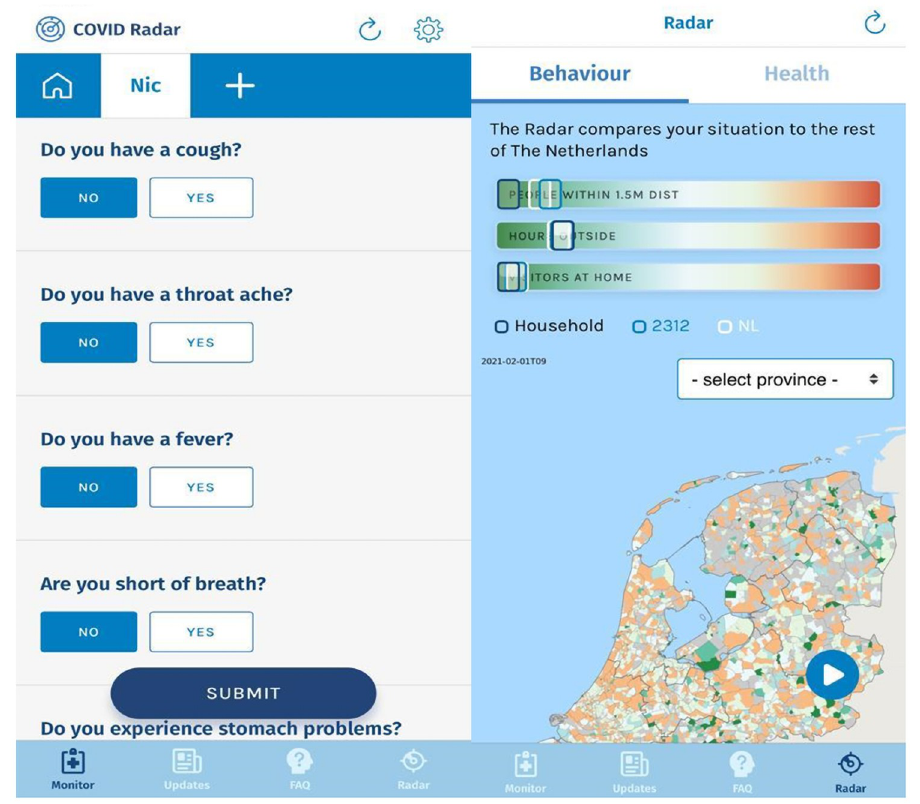
Fig 1. Screenshot of COVID radar app (Left: Questions. Right: Feedback) “Reprinted from “urlmaps.com” under the Creative Commons Attribution License, with permission from “i-mapping”, original copyright 2021”.